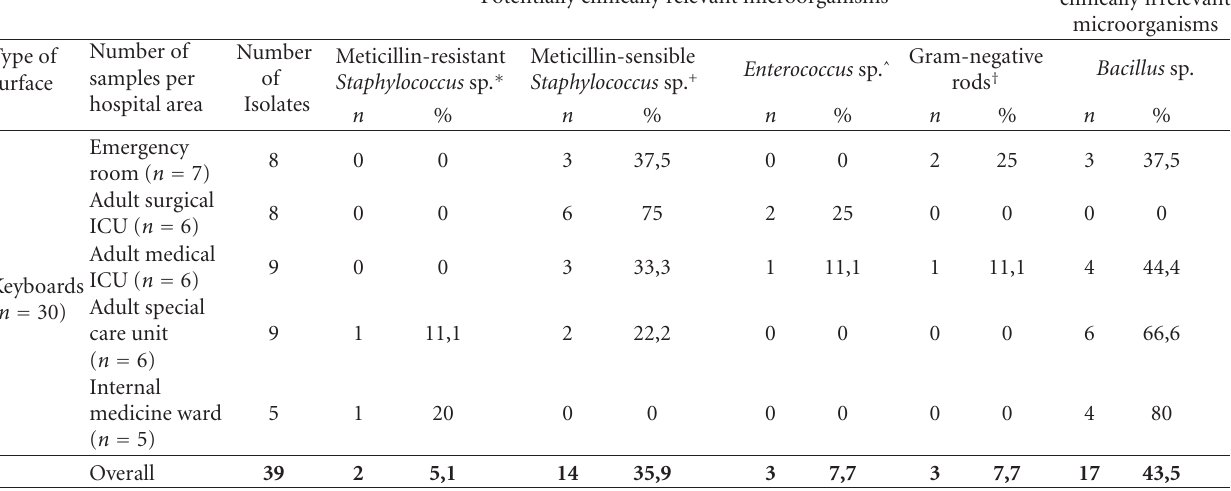
Table 1: Distribution of bacterial isolates from